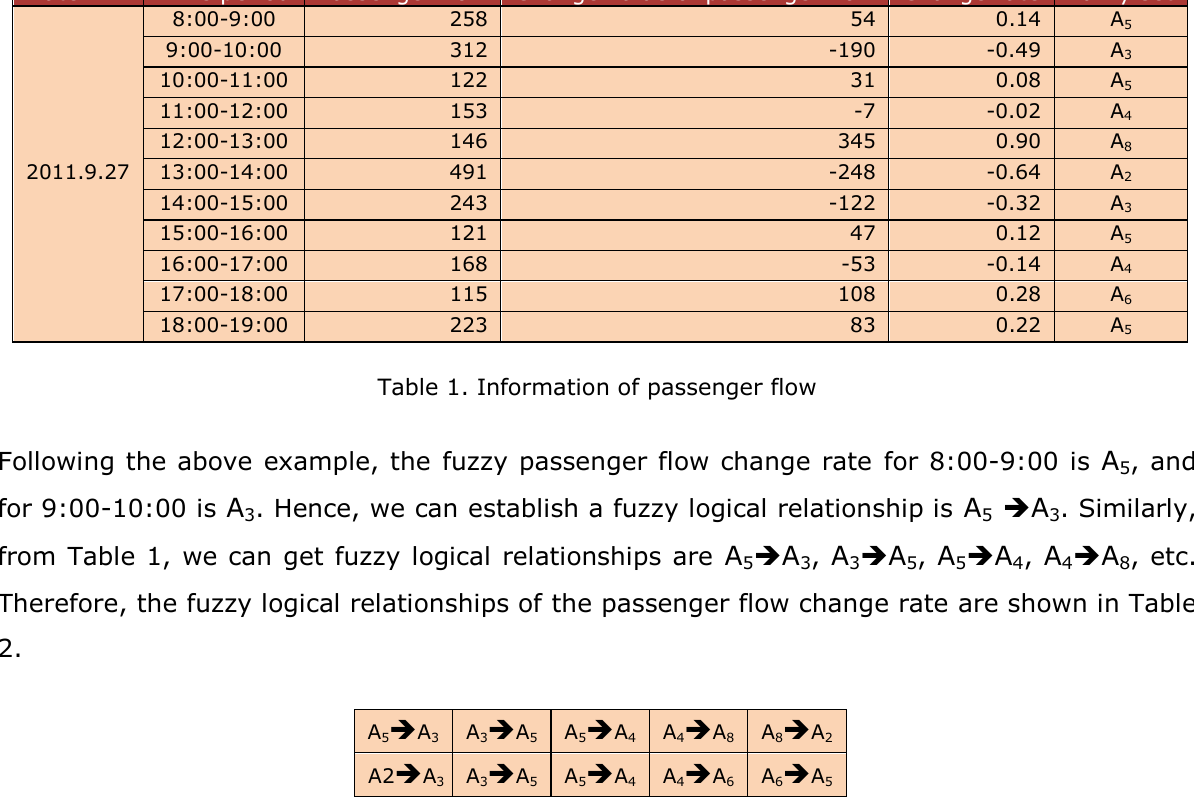
Table 2. Fuzzy logical